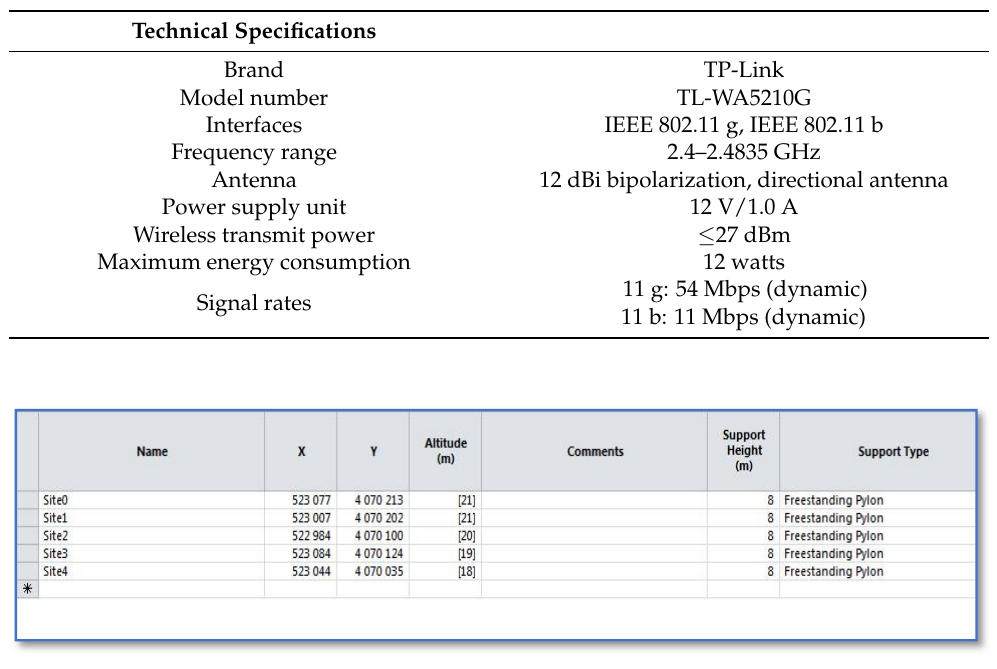
Figure A1. Introduction of site properties in ATOLL.